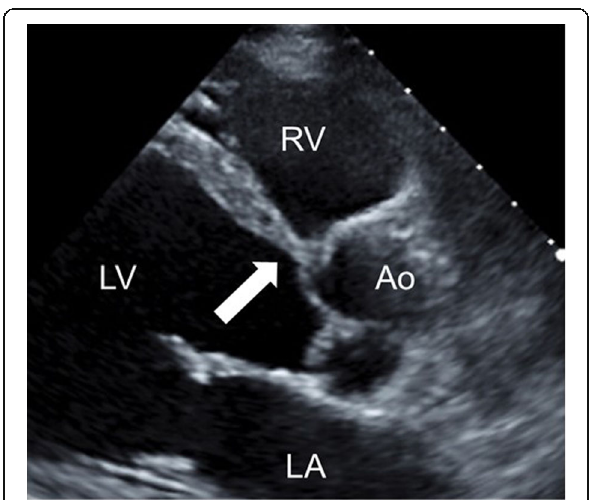
Fig. 1 Abnormal thinning of the basal ventricular septum. A parasternal long-axis transthoracic echocardiography view at the level of the aortic valve showing abnormal ventricular septal thinning with a minimal thickness of 4.4 mm (arrow). LA left atrium, LV left ventricle, RA right atrium, RV right ventricle, Ao